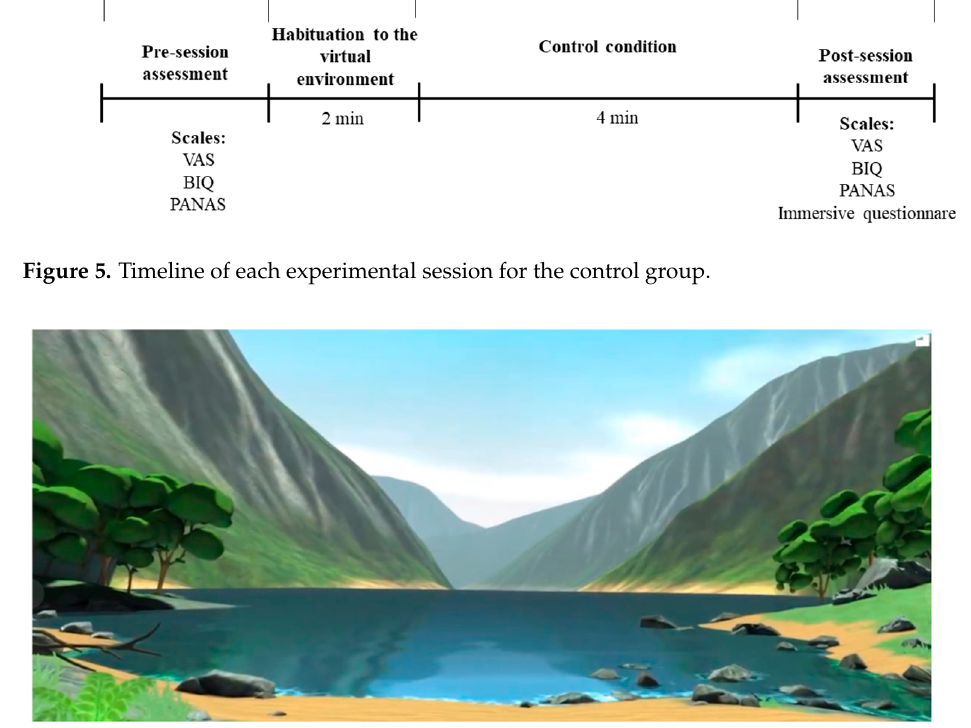
Figure 6. Caption of the pleasant virtual environment retrieved from the Calm Place app.